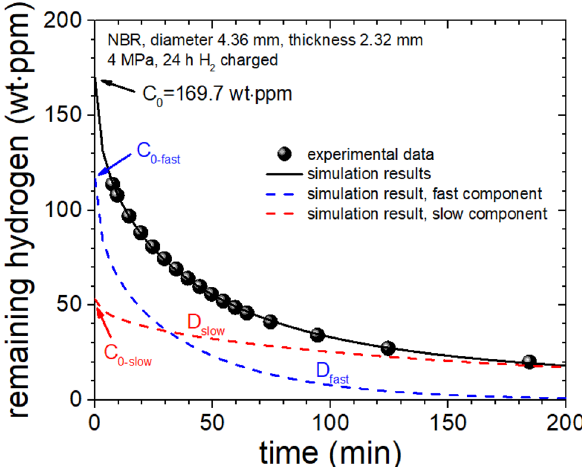
Figure 7. H 2 residue data and simulation results over time after decompression with program. After parameter fitting using self-developed program, the graph was redrew with the experimental and simulation data using two components diffusivities, D fast and D slow and H 2 residue C 0-fast and C 0-slow